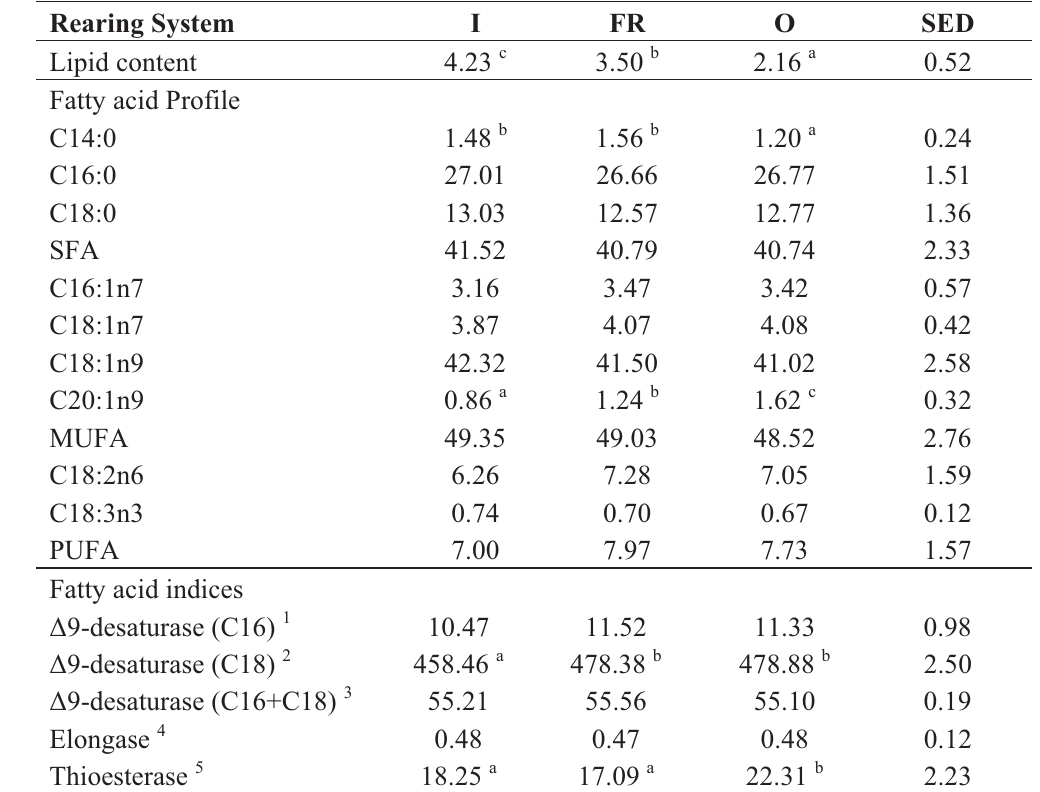
(g/100 g of total lipids) and fatty acid indices of Longissimus dorsi